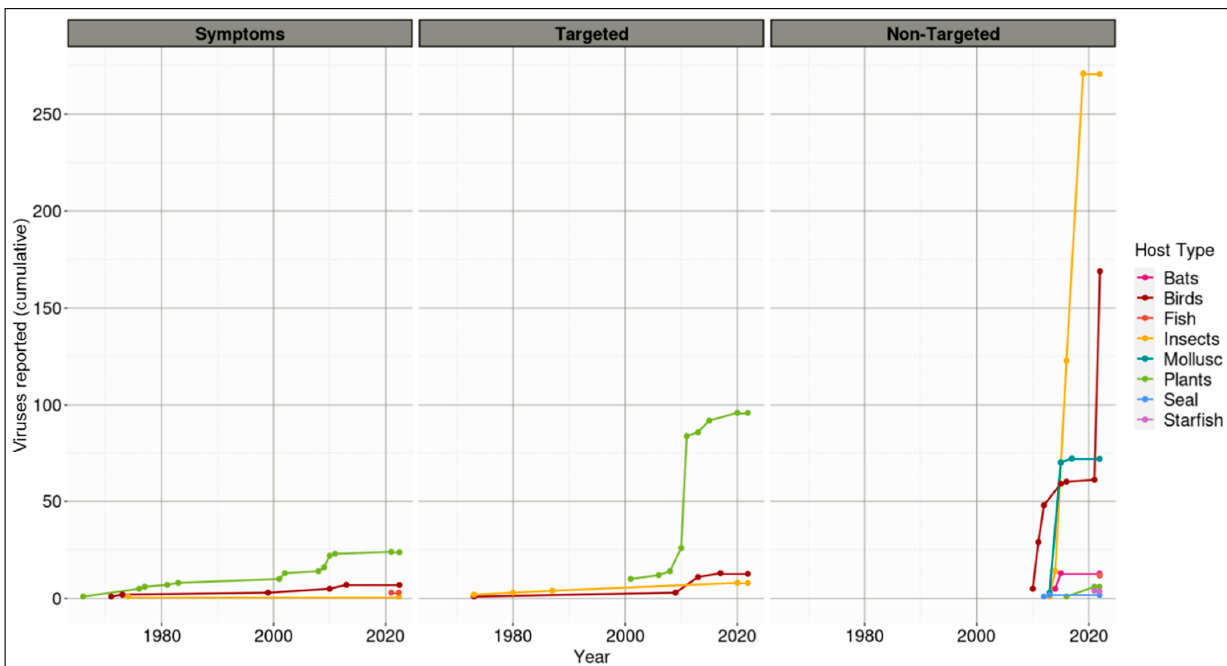
Figure 2. Total accumulated viruses reported (prior to 28 February 2022) associated with an Aotea- roa New Zealand indigenous host, dependent on host type and detection